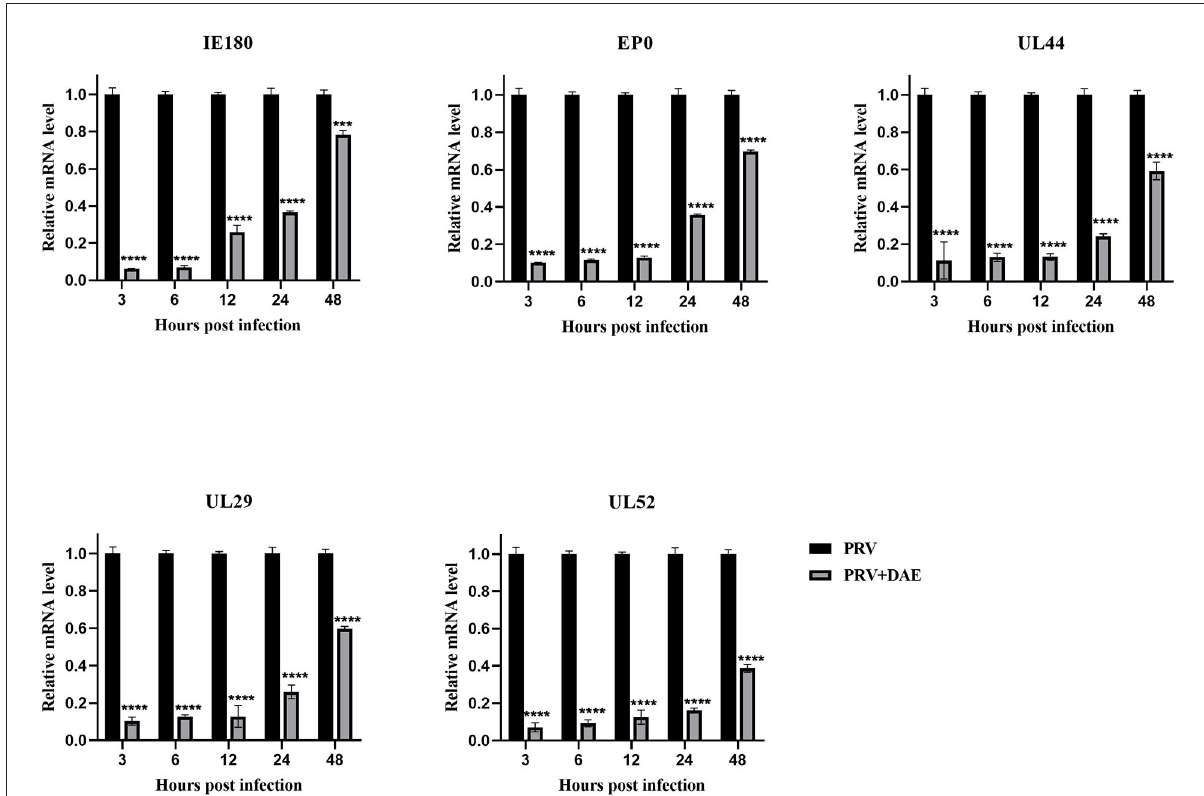
FIGURE4 DAE suppressed the expression of PRV genes. In the presence or absence of emodin, the expression of PRV genes (IE180, EP0, UL52, UL29, and UL44) was detected by relative quantitative PCR at 3, 6, 12, 24, and 48 hpi ( n = 3 in each group) (**** P < 0.0001, *** P < 0.001).